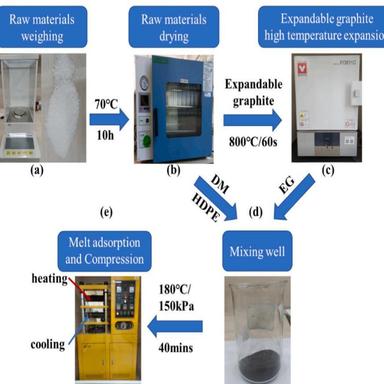
Schematic illustration of the fabrication process of the CPCM.